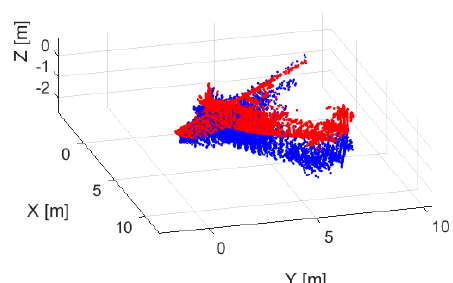
Figure 9. Comparing the robustness of the 3D (blue) and the 2-DoF 3D ICP